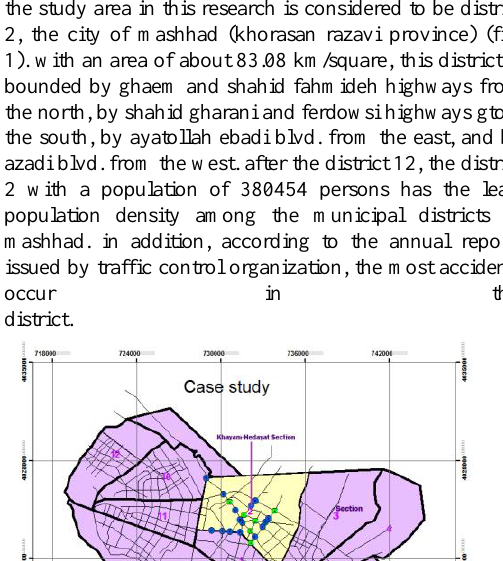
figure. 2 check points' status in terms of